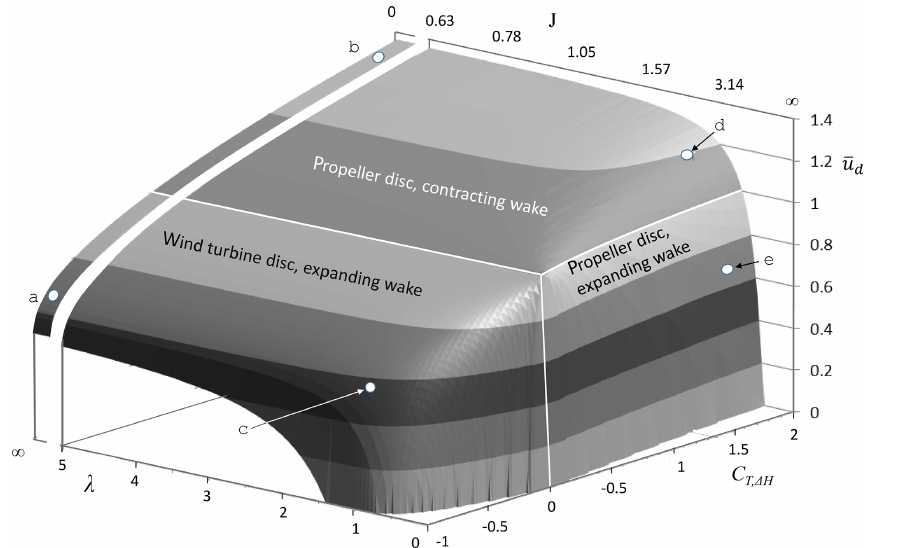
Figure 3. The axial velocity u d for wind turbine discs ( − 1 < C T,(cid:49)H ≤ 0) and propeller discs (0 ≥ C T,(cid:49)H < 2) for 0 ≤ λ ≤ 5 and for λ = ∞ . The white markers a to e refer to flow cases defined in Table 1 and analysed in the next sections. The figure is a modified version of van Kuik (2018b, Fig.